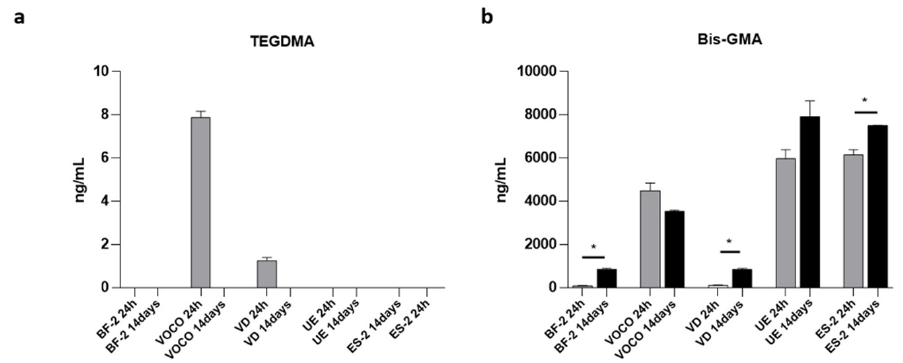
Figure 2. LC–MS/MS quantification. Levels of ( a ) TEGDMA and ( b ) Bis-GMA quantified in culture media following 24 h (in grey) and 14 days (in black) of CR disk immersion. Results are shown as mean ± standard error (SEM) ( n = 3) (* p < 0.05 vs. 24 h).